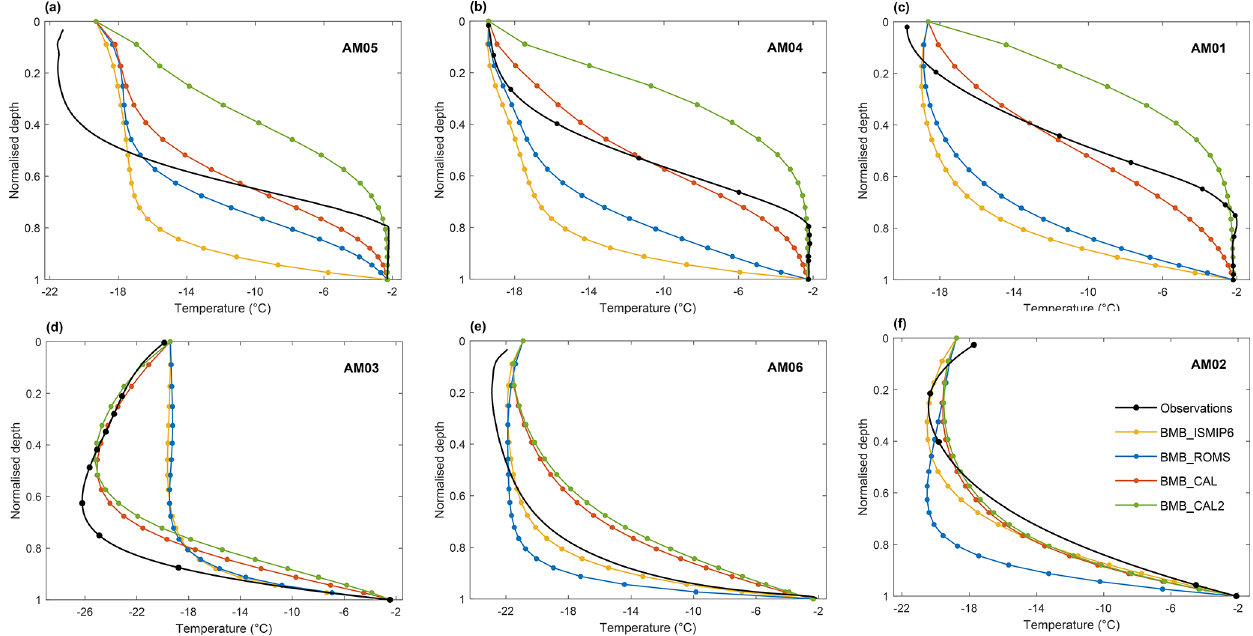
Figure 7. Normalised-depth comparisons between measured and simulated temperature profiles at six borehole sites, shown in Fig. 1. AM05, AM04 and AM01 (a, b, c) are on the JP flowline from upstream to downstream with marine ice. AM03, AM06 and AM02 (d, e, f) are from upstream to downstream, experiencing basal melting. Observed temperature profiles are derived from the borehole thermistor (AM01–AM04) and DTS data (AM05, AM06). The 3-D model has 20 layers in the vertical, with circles indicating